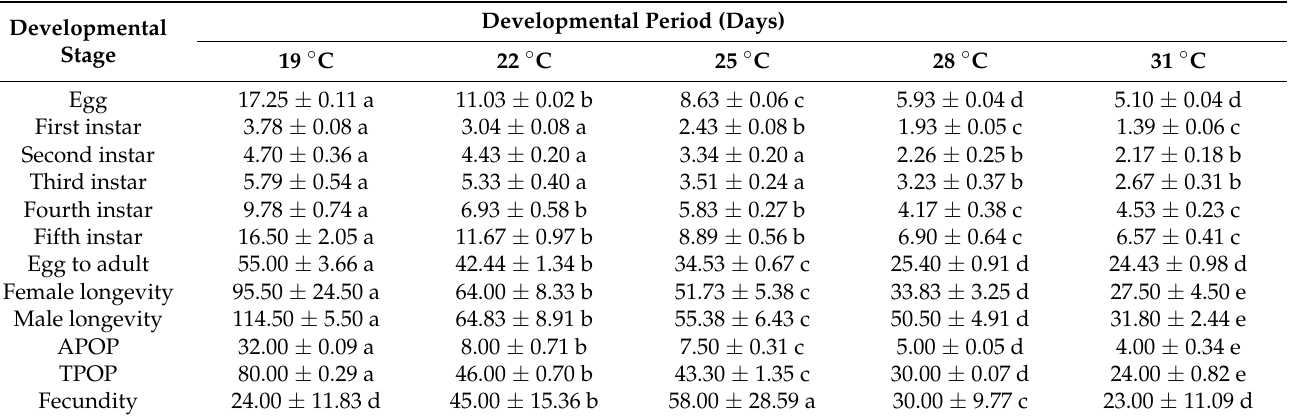
Table 1. Developmental periods of Riptortus pedestris reared at different